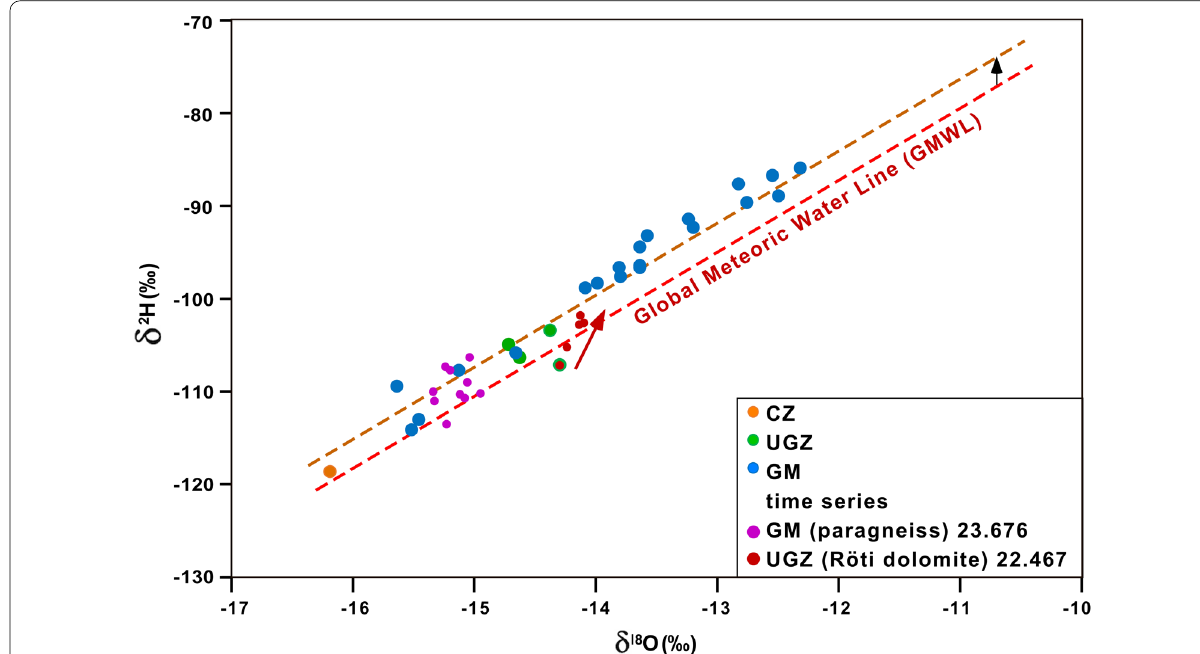
Fig. 10 Stable isotope composition of tunnel water with respect to GMWL (red). Inflow water follow a trend (orange) parallel to the GMWL with a shift of δ 2 H 3 ‰ (black arrow). Also shown are the time series in the GM-Paragneiss (TM = (TM 22.460 km) marked with red arrow. Accuracy of determination: δ 18 O =